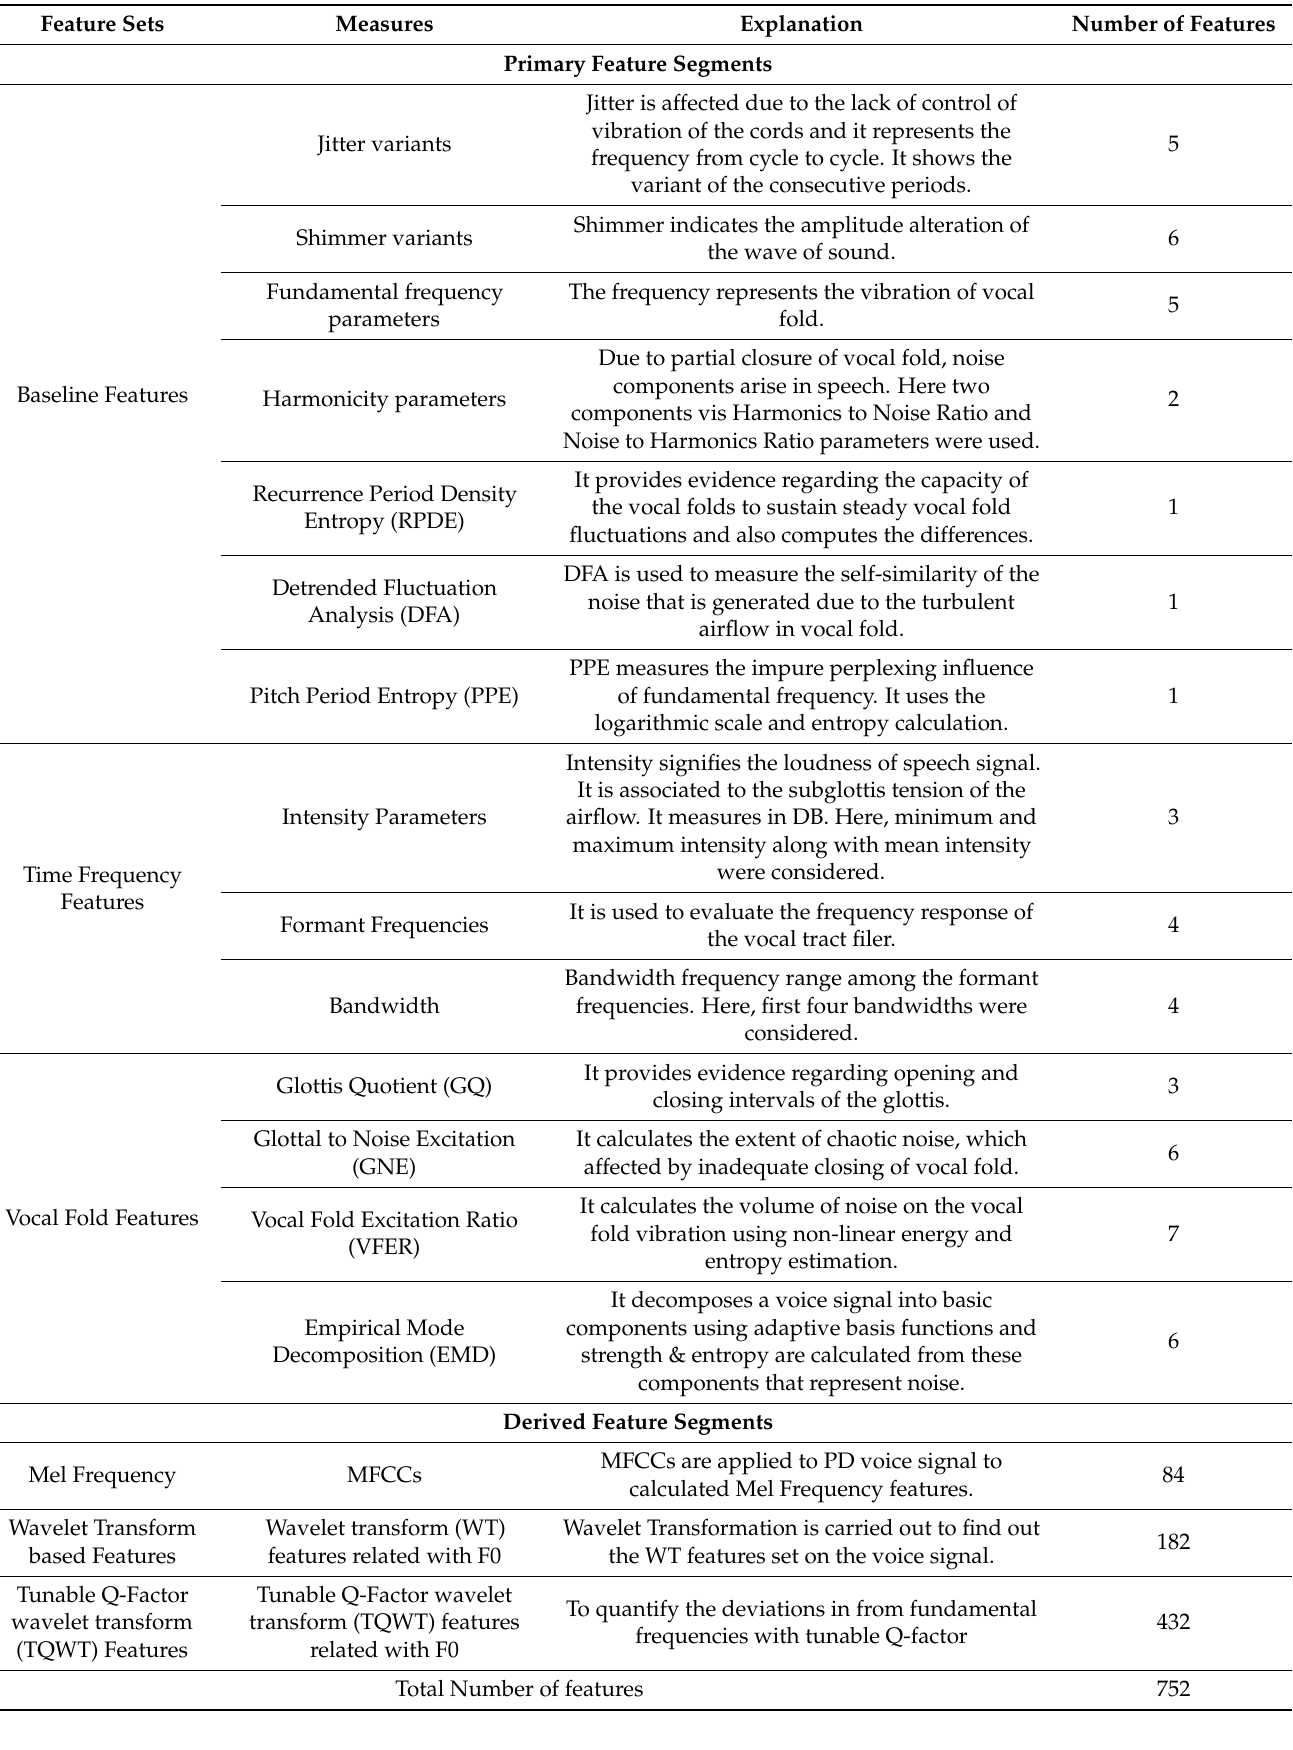
Table 1. General structure of Istanbul acoustic